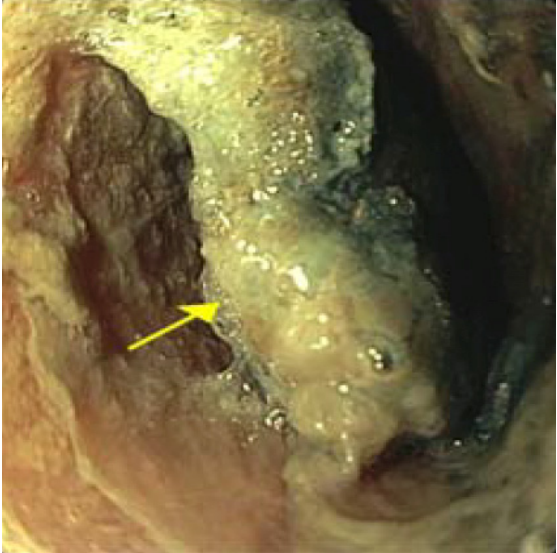
Figure 2. Endoscopy six hours following initial ingestion of the button battery. It shows significant wall necrosis with the yellow arrow identifying the button battery impacted in the middle esophagus and covered with secretions.